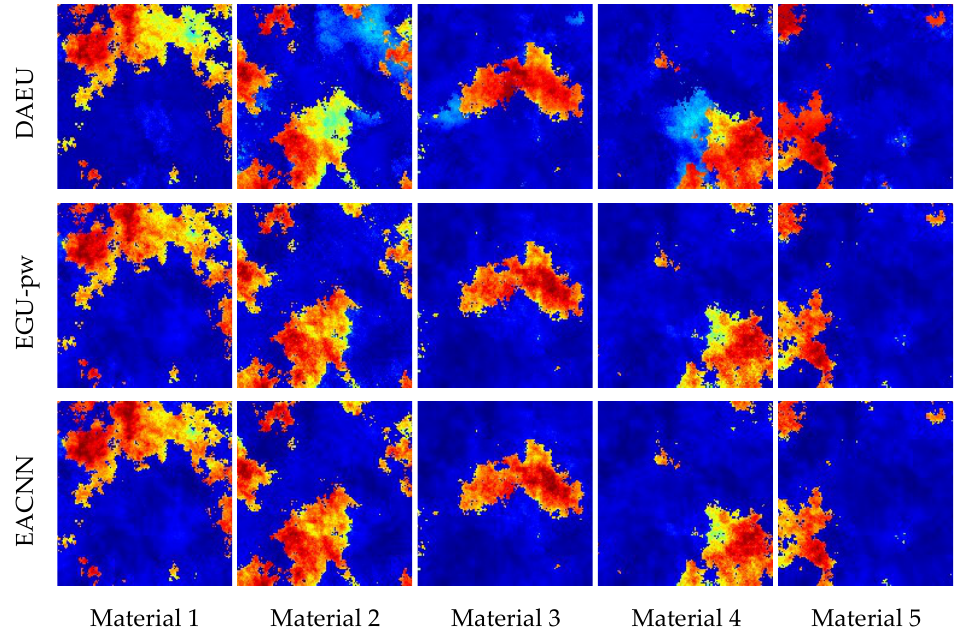
Figure 4. The abundance result for the synthetic data estimated by the proposed methods. Table 3. Experimental results for the synthetic data. The best one is shown in bold.